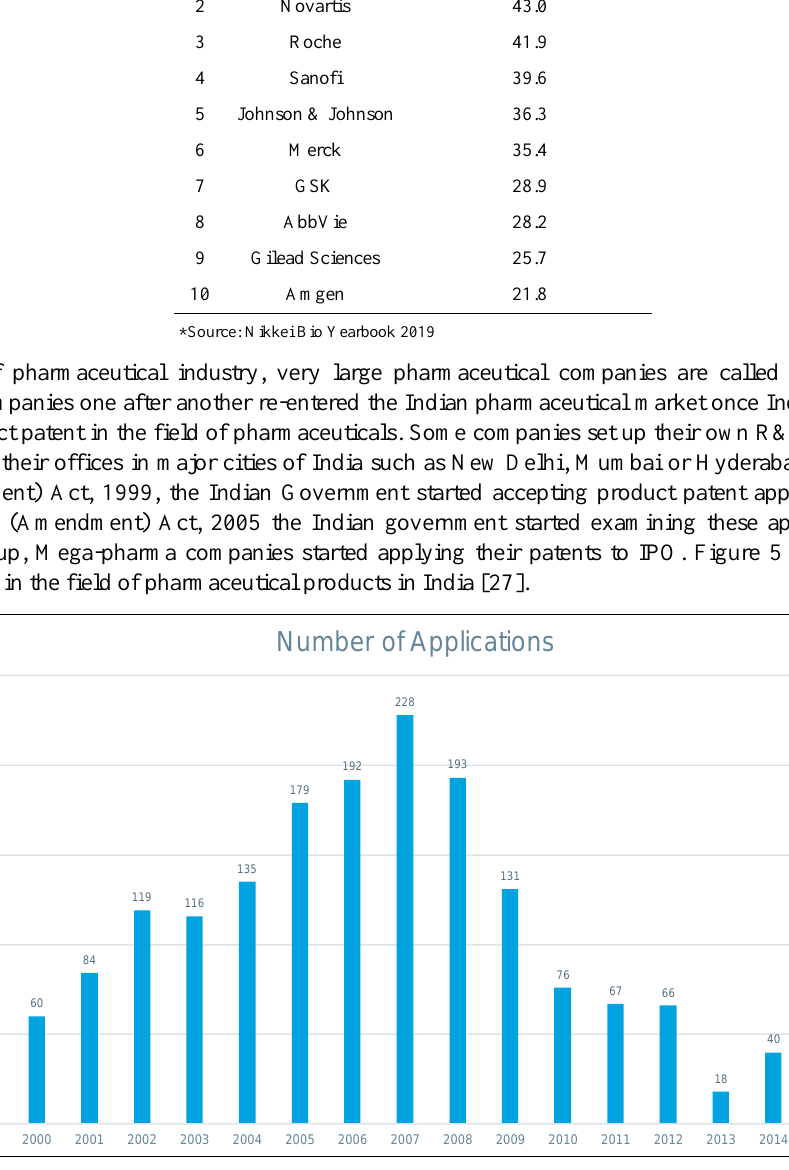
Figure 5. Number of Patent Application 1999 ‐ 2015, IQVIA 2017